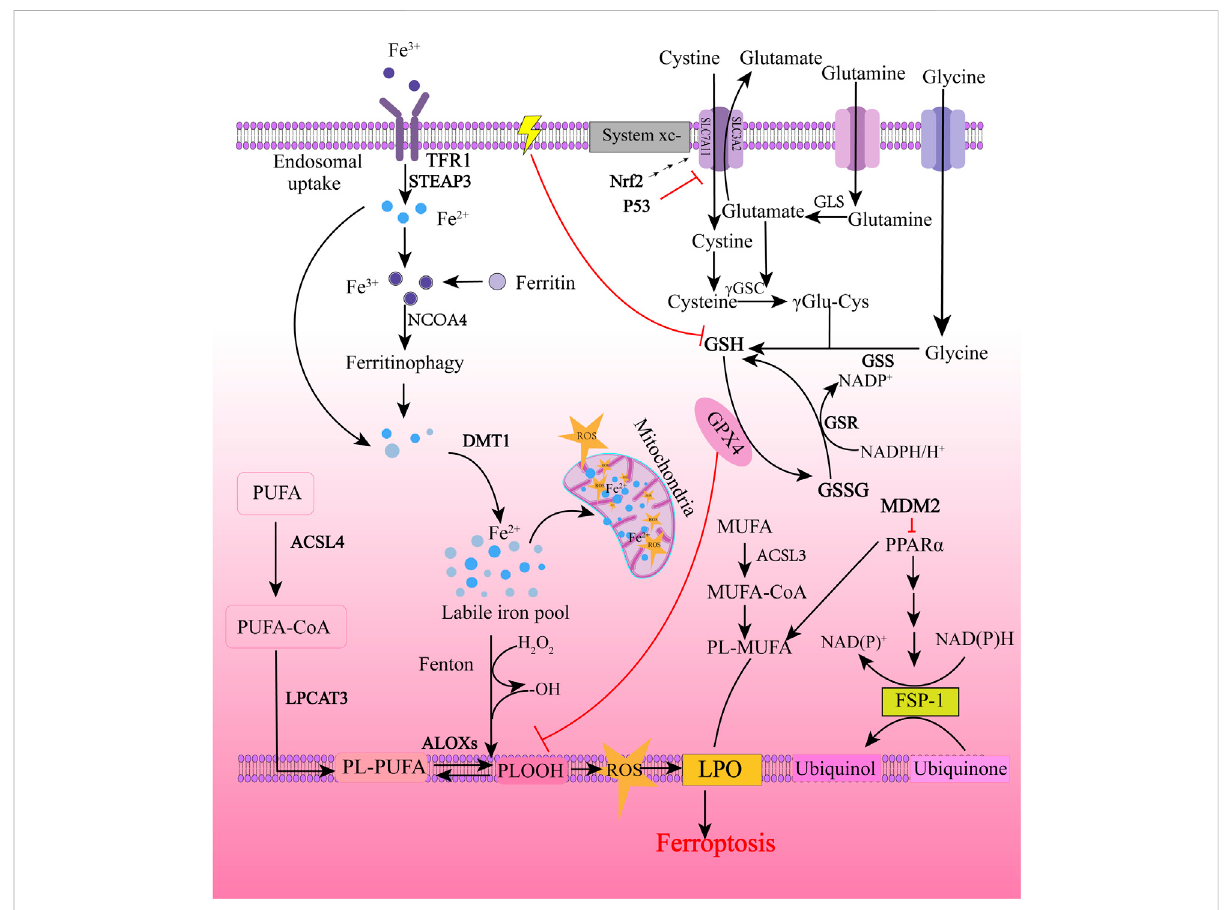
FIGURE 2 Molecular regulatory mechanism of ferroptosis. Ferroptosis is primarily initiated through two pathways: exogenous (transferrin dependent) pathways and endogenous (enzymatically regulated) pathways. The extrinsic pathway is initiated by cell membrane transporters such as cystine/ glutamate transporter or by ferroportin, transferrin and lactoferrin activation. The endogenous pathway is activated by blocking intracellular antioxidant enzymes such as GPX4. The background color is from light to dark, with the light color representing exogenous pathways and the dark color representing endogenous pathways. TFR1, transferrin receptor 1; STEAP3, the six-transmembrane epithelial antigen of the prostate 3; NCOA4, nuclear receptor coactivator 4; DMT1, divalent metal transporter 1; ROS, reactive oxygen species; ACSL4, acyl-CoA synthetase long-chain family member 4; LPCAT3, lysophosphatidylcholine acyltransferase 3; ALOXs, arachidonic acid lipoxygenases; PUFA, polyunsaturated fatty acids; PUFA-CoA, polyunsaturatedfattyacylCoA;PL-PUFA,phospholipid-boundpolyunsaturatedfattyacids;PLOOH,phospholipidhydroperoxides;LPO, lipidperoxidation;Nrf2,nuclearfactorerythroid2-relatedfactor2;GLS,Glutaminase; γ -GSC, γ -glutamylcysteinylsynthetase; γ Glu-Cys, γ glutamyl- cysteine; GSH, glutathione; GSS, glutathione synthetase; GSR, glutathione-disul fi de reductase; GSSG, glutathione oxidized; GPX4, glutathione peroxidase 4; ACSL3, acyl-CoA synthetase long-chain family member 3; MUFA, monounsaturated fatty acids; MUFA-CoA, monounsaturated fatty acylCoA; PL-MUFA,phospholipid-boundmonounsaturatedfattyacids;PPAR α ,peroxisomeproliferator-activatedreceptor α ;NADPH,nicotinamide adenine dinucleotide phosphate; NADP + , the oxidized form of NADPH; FSP-1, ferroptosis-suppressor-protein 1. “ ⊥ ” represents